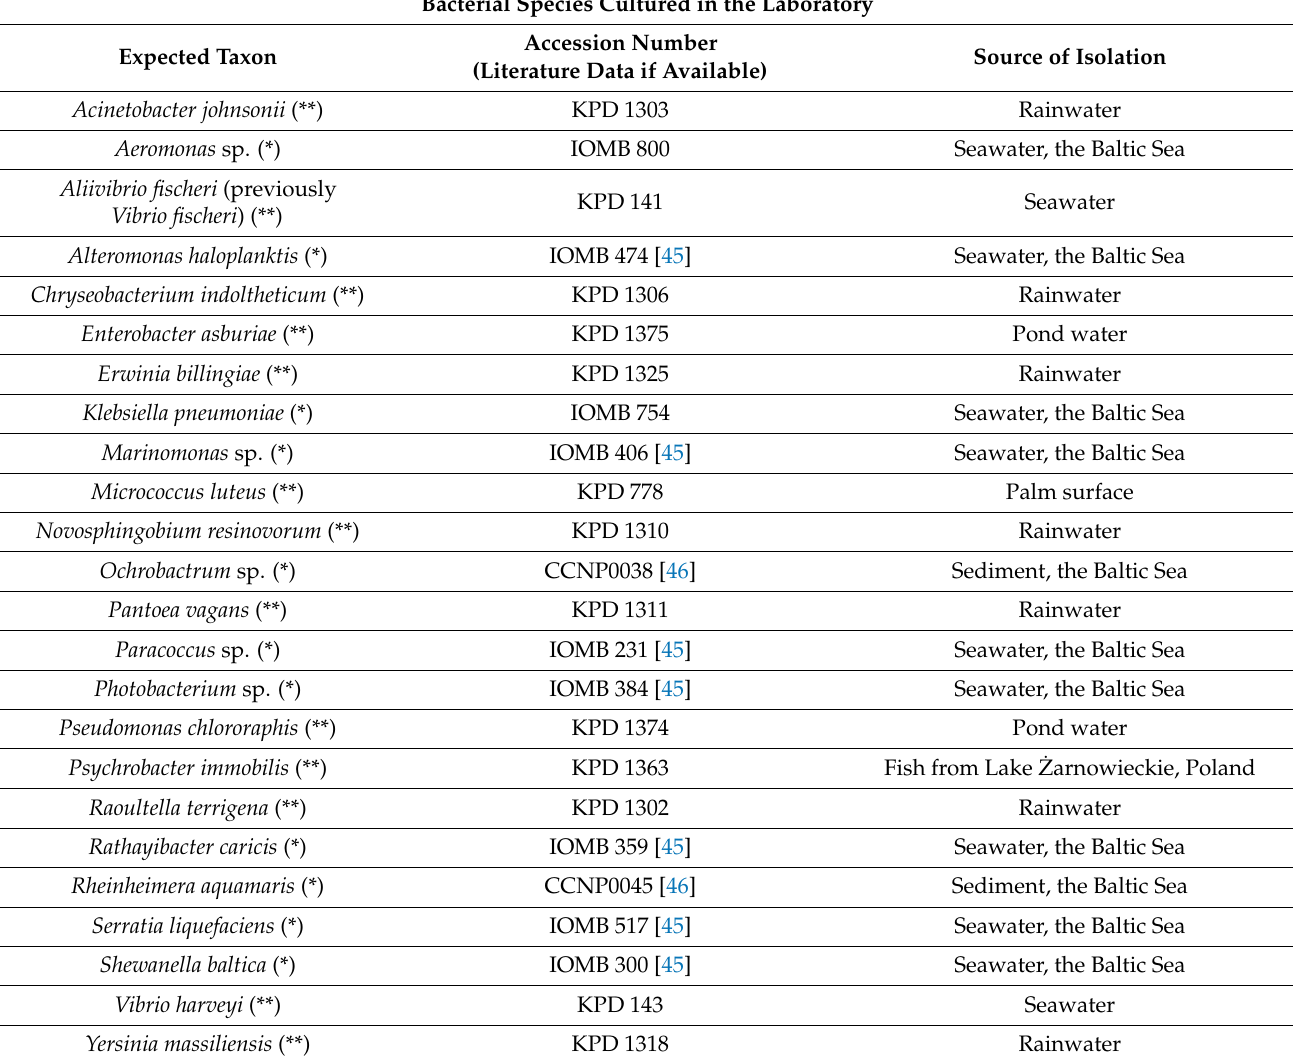
Table 1. Microbial composition of the “mock communities”: bacterial species cultured in the labora- tory and ZymoBIOMICS™ Microbial Community DNA